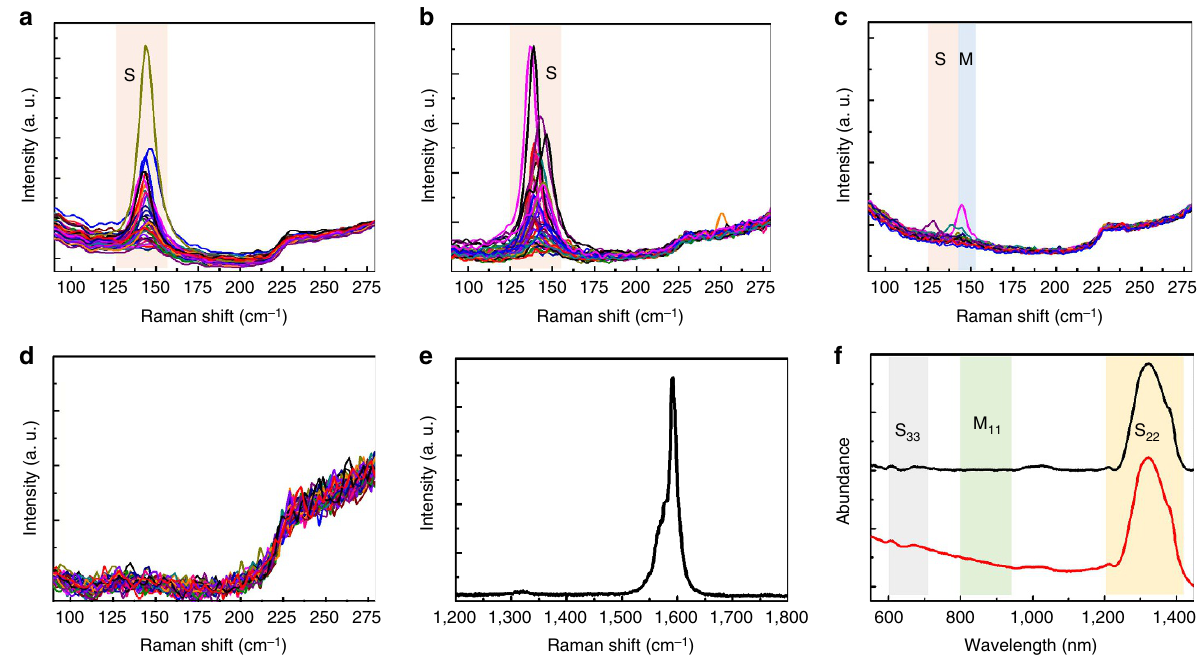
Figure 4 | Electrical type of the SWCNTs. Electrical type characterized by multi-wavelength Raman spectroscopy and ultraviolet/visible/near-infrared absorption spectroscopy. Raman spectra of the SWCNTs measured with ( a ) 532, ( b ) 633, ( c ) 785 and ( d ) 488nm lasers. The regions corresponding to semiconducting and metallic transitions are labelled as S (pink) and M (blue), respectively. ( e ) D and G band excited with a 633-nm laser. ( f ) Ultraviolet/ visible/near-infrared absorption spectrum of an aqueous dispersion collected from 125 SWCNT samples: as-collected curve (red line) and background- subtracted curve (black line).